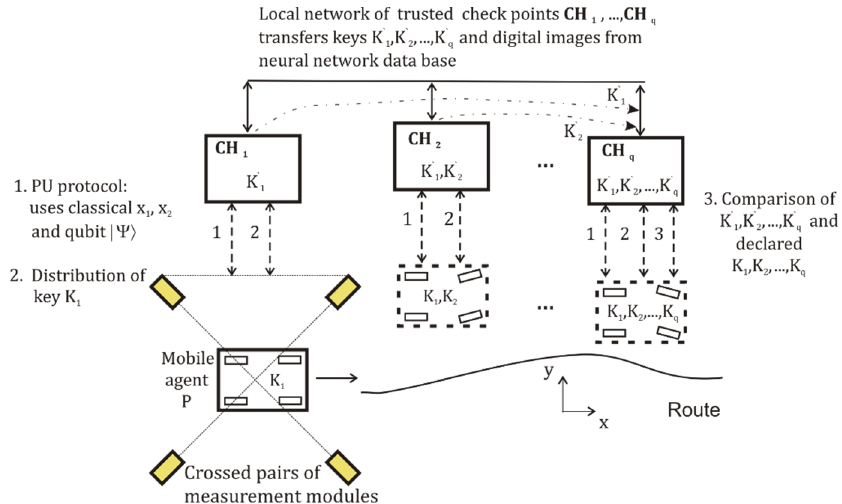
Figure 2. The principal scheme of quantum route verification of a mobile agent M, uniting methods proposed in [32,79].